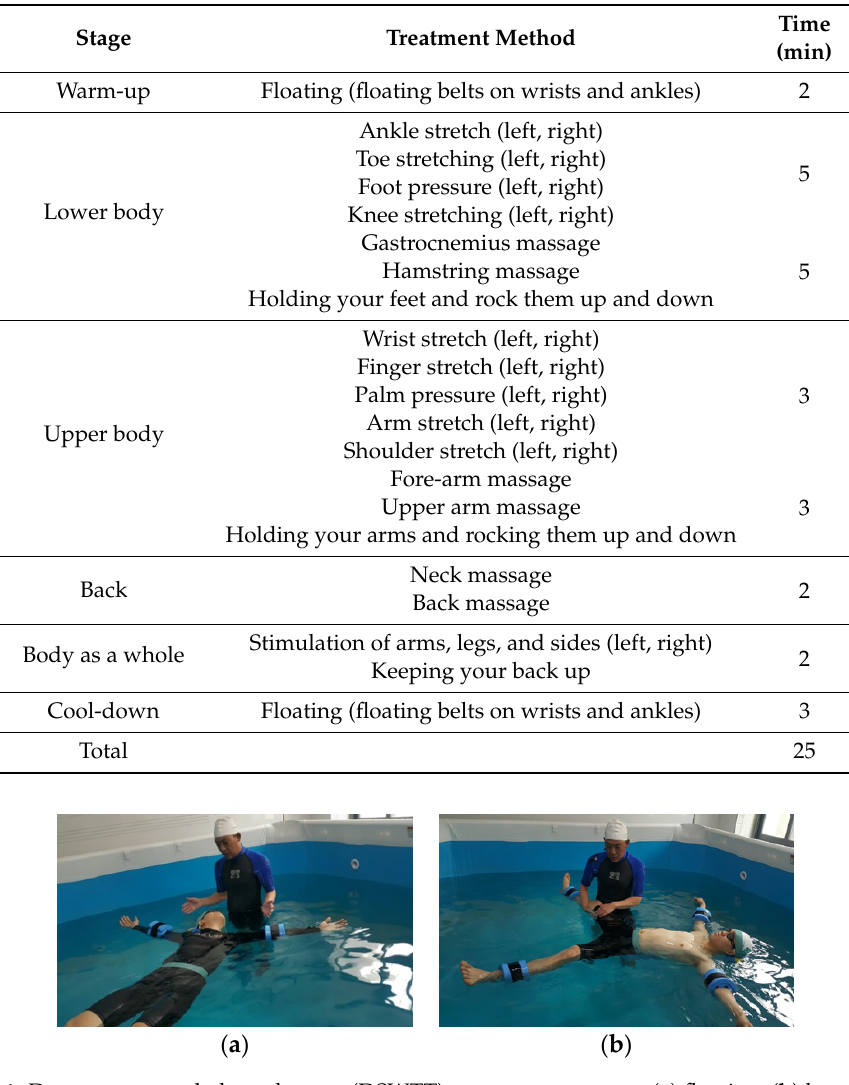
Figure 1. Deep-sea water thalassotherapy (DSWTT) treatment program: ( a ) floating; ( b ) lower body.